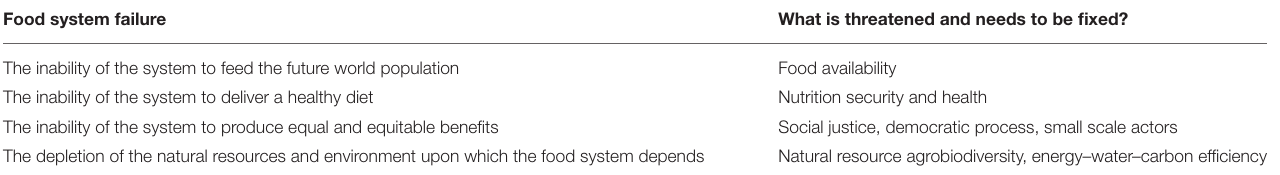
TABLE 1 | Different narratives about the failure of the food system [extracted from Béné et al.